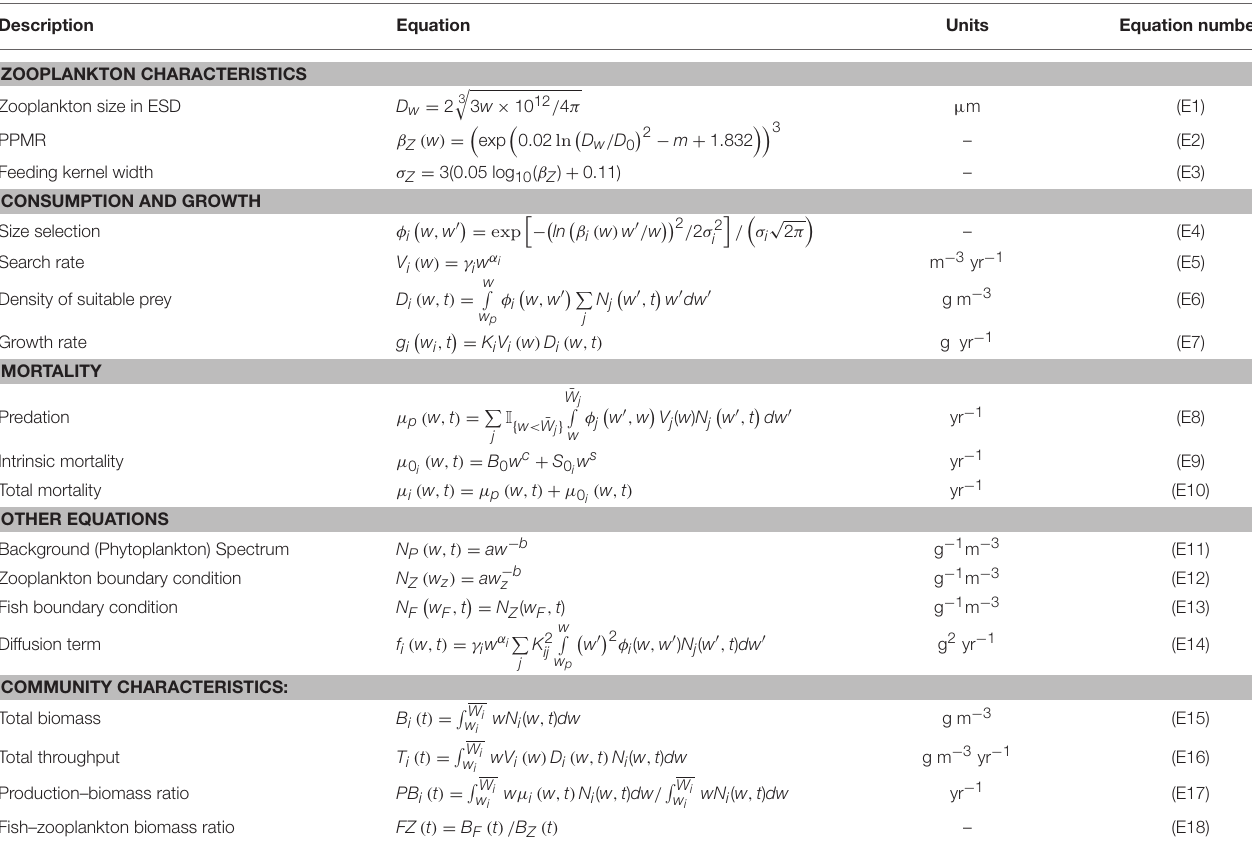
TABLE 2 | Model equations with their units. Description Equation Units Equation